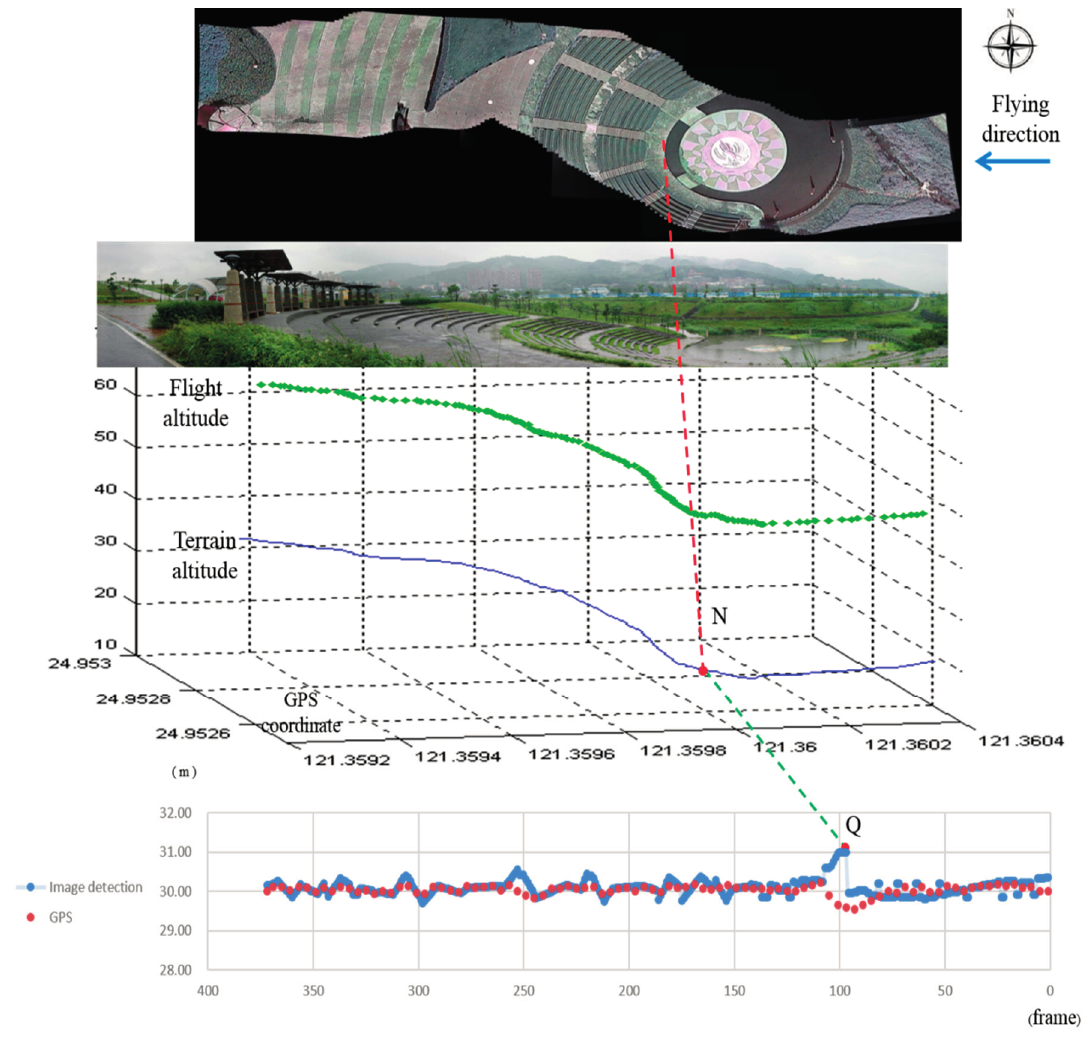
Figure 11. Experimental results from the proposed